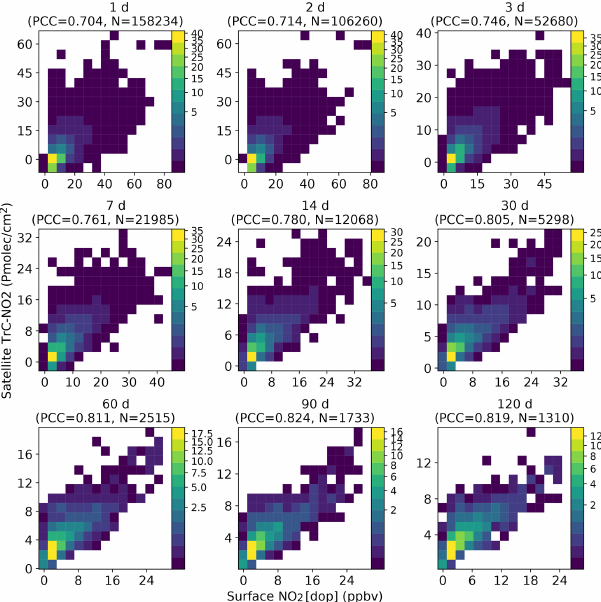
Figure 4. Density scatter plot of TROPOMI TrC-NO 2 against surface NO 2 mixing ratios at TROPOMI overpass time (dop timescale), averaged over different time